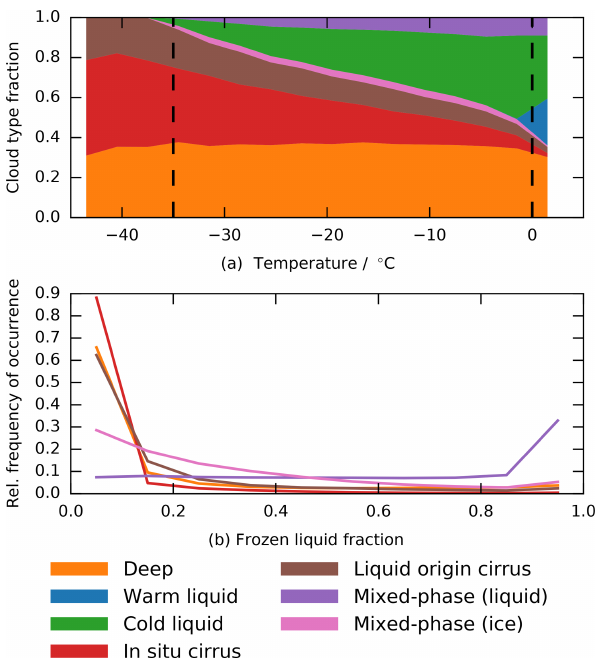
Figure 13. Cloud type fraction as a function of grid box tempera- ture (a) and frequency of occurrence of frozen liquid fraction (b)